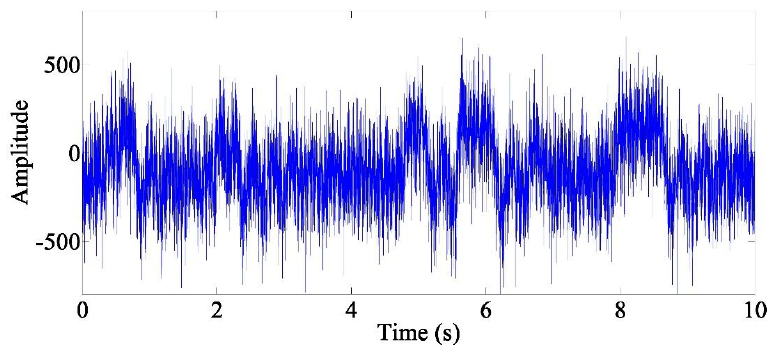
Figure 18. The time-domain waveform of the collected signal.